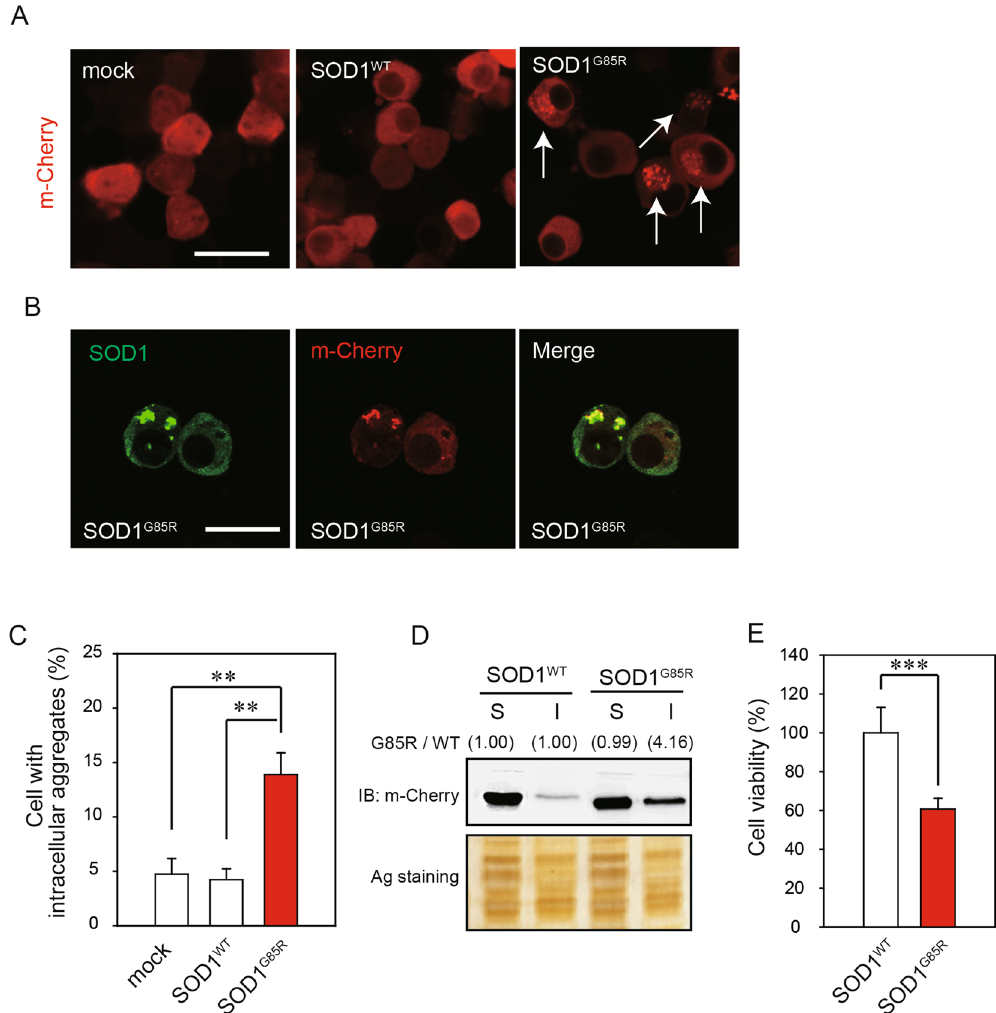
Figure 1. SOD1 G85R caused neurotoxicity via the formation of insoluble aggregates. ( A ) Representative fluorescent microscopy images of N2a cells expressing mCherry-SOD1 WT or mCherry-SOD1 G85R . The arrowheads indicate the intracellular SOD1 aggregates. ( B ) Colocalization of SOD1 and mCherry in the N2a cells. ( C ) Quantified data of intracellular SOD1 aggregates are expressed as mean ± S.E.M from three independent experiments. In each experiment, at least 200 cells were counted. ( D ) Immunoblot analysis of SOD1 aggregates. N2a cells expressing SOD1 constructs were lysed with 1% TritonX-100 (Triton soluble fraction; S). Triton-insoluble fraction (I) were resuspended with 2% SDS and then analyzed with immunoblotting by anti-mCherry antibody. ( E ) N2a cells expressing mCherry-SOD1 WT or mCherry- SOD1 G85R were incubated for 48 h in the differentiation medium. The cell viability was measured by MTT assay. ** p < 0.01, *** p < 0.001. Scale bar: 50 µ